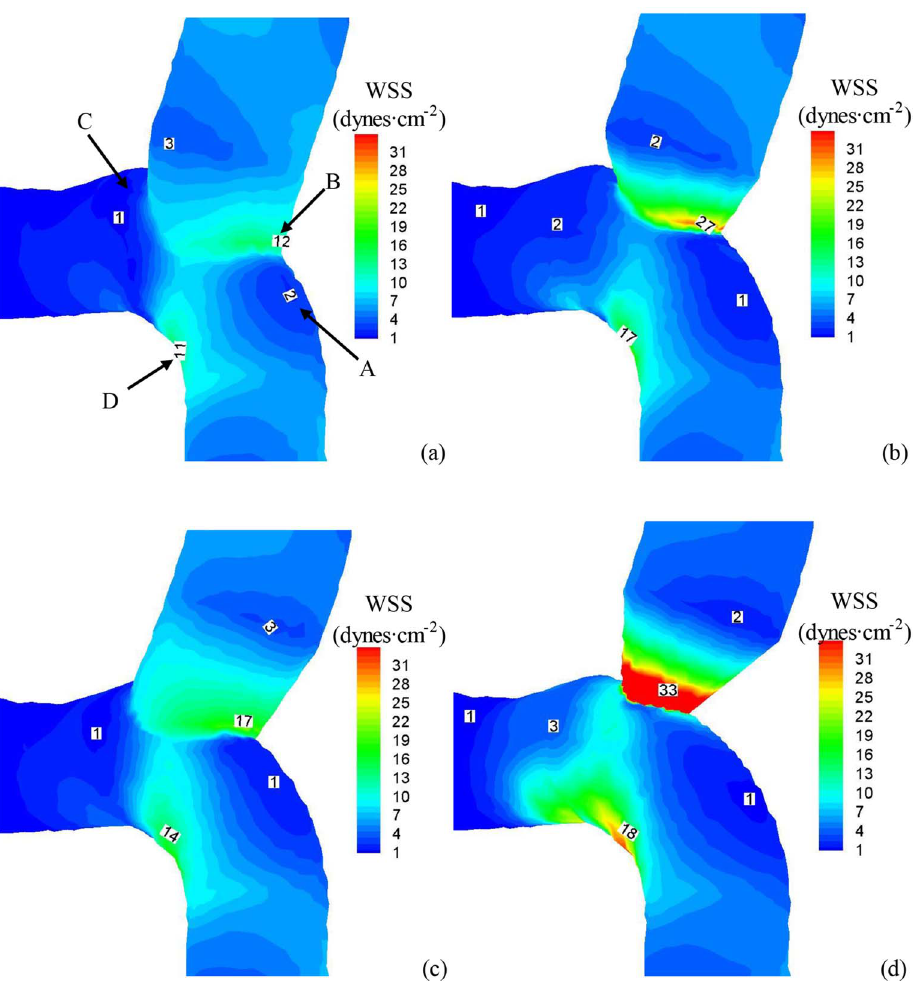
Figure 4. The distribution of time-averaged (over a cardiac cycle) WSS (Unit: Dynes ? cm 2 2 ) at the anastomosis between SVG and ~ 1 and h =45 6 (an idealized case, where CSA coronary artery for geometrical models as: (a) CSA graft graft equal to the CSA of proximal CSA artery ~ 1 ~ 1 and h =85 6 (a simulated increase of and h =45 6 (a simulated decrease of graft CSA); (c) CSA graft artery in Fig. 3e); (b) CSA graft CSA artery CSA artery 2 ~ 1 graft angle); and (d) CSA graft and h =85 6 (a simulated decrease of graft CSA as well as a simulated increase of graft angle). Region A 2 CSA artery refers to the toe region in coronary artery while Region B is the toe region in venous graft. Region C refers to the heel region. Region D represents coronary artery wall opposite to junction